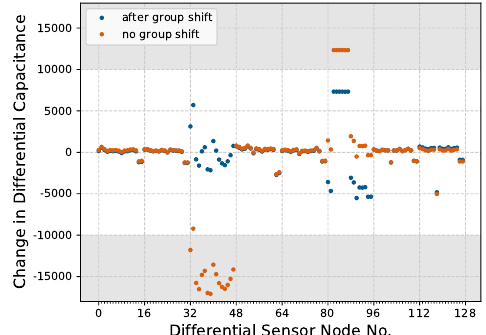
Figure 6: Change in differential capacitance for a drilling attack affecting two Tx groups (before and after normalization). The grey area denotes values within the range of non-linear effects.